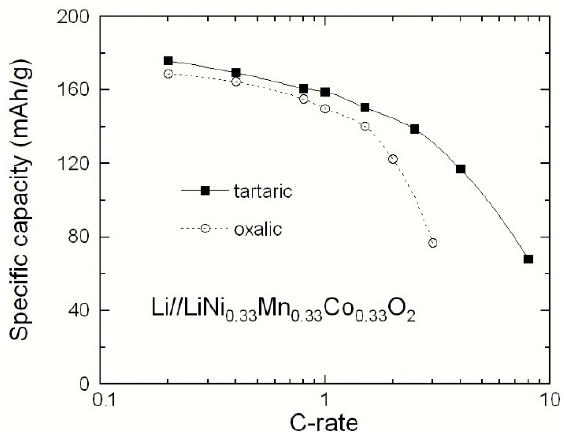
Figure 15. Peukert plots showing the difference in the electrochemical performance of LiNi 1/3 Mn 1/3 Co 1/3 O 2 electrodes synthesized using wet-chemical method assisted by oxalic and tartaric acid.